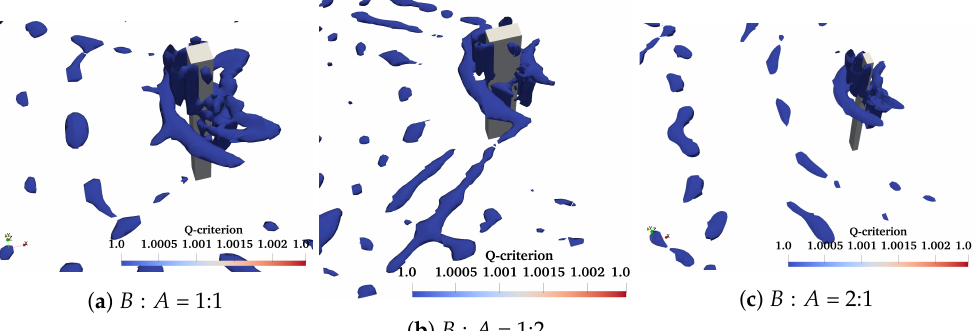
Figure 17. Isosurfaces visualizing turbulent structures for Q = 1 s − 2 , KC number = 10, and wave current parameter ( U cw ) = 0.4 with different aspect ratios of the rectangular